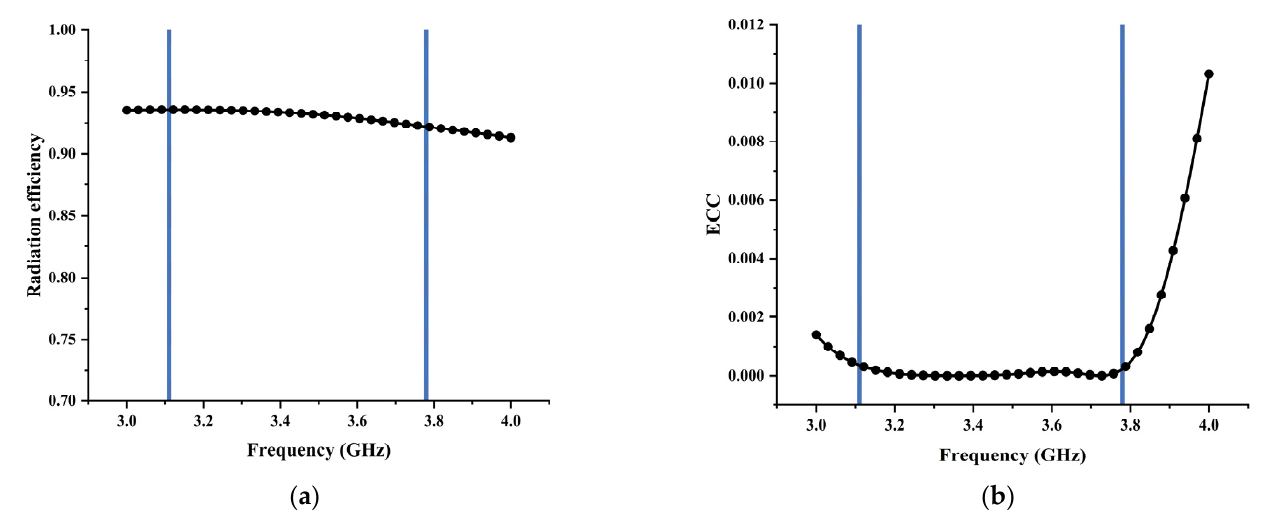
Figure 21. ( a ) The simulated radiation efficiency; ( b ) the calculated ECC.